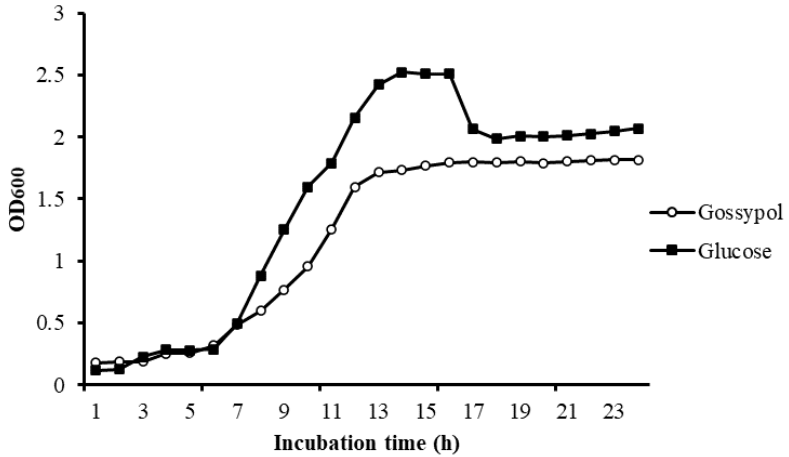
Figure 4. Phylogenetic tree based on 16S rDNA sequence of gossypol-degradation strain L. agilis WWK129.